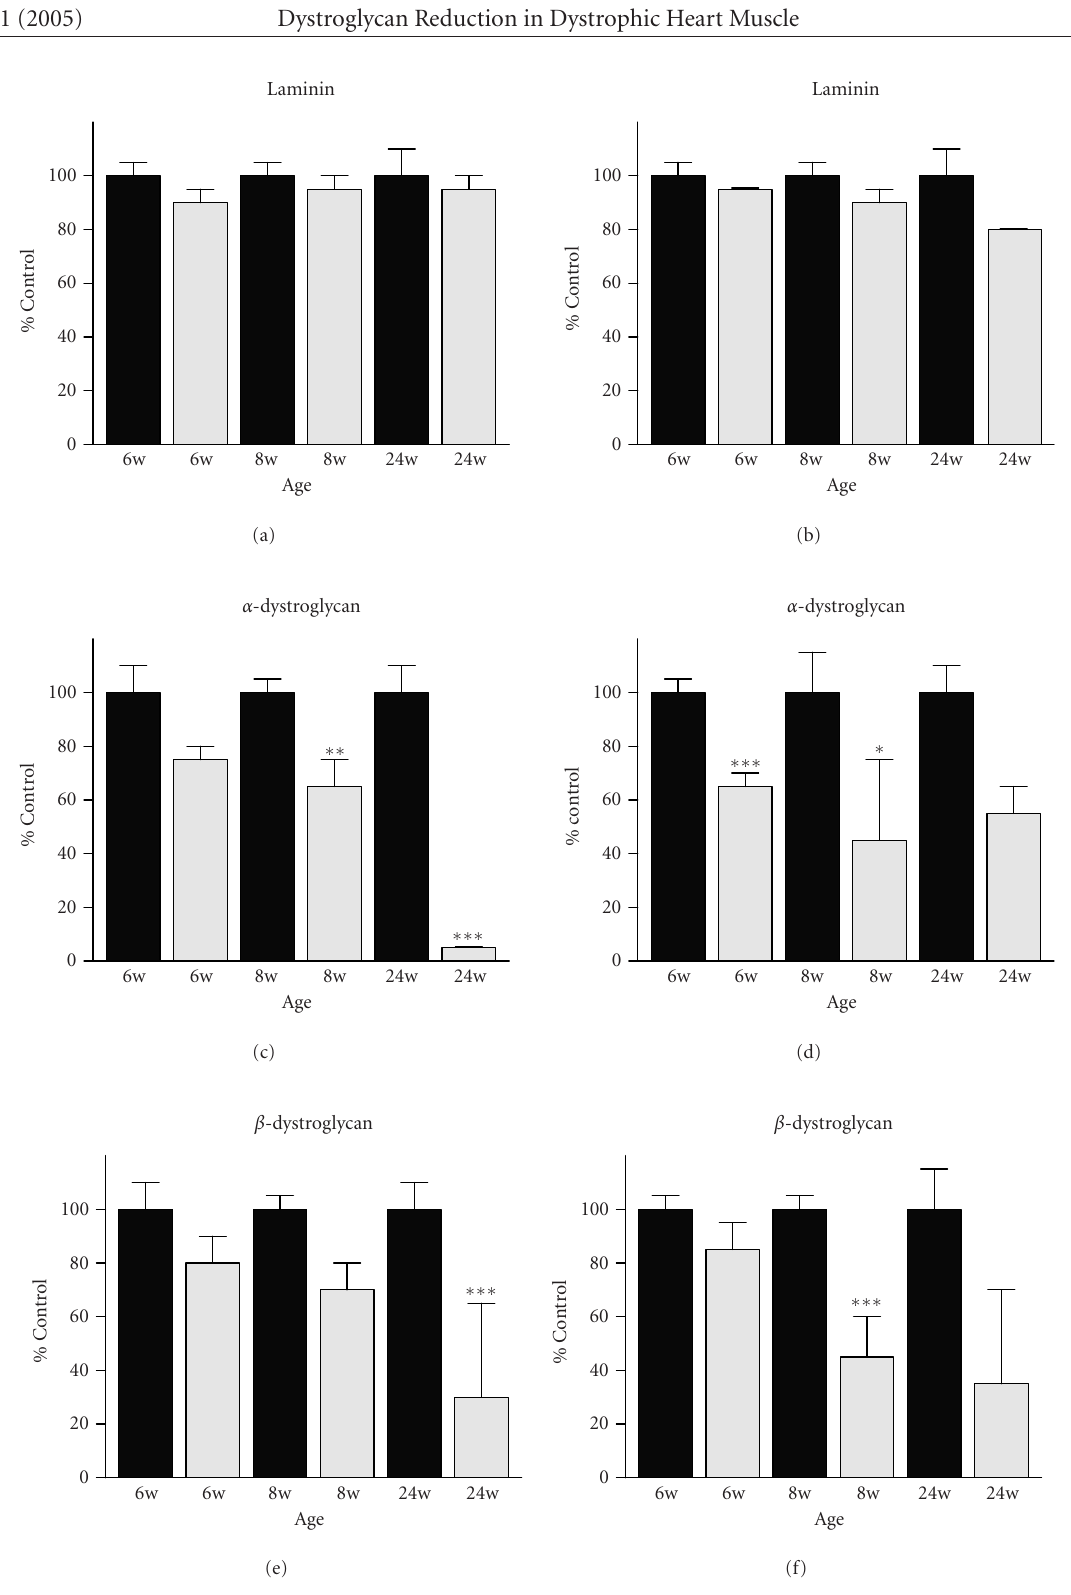
Figure 4. Comparative immunoblot analysis of dystroglycan expression in dystrophic heart and skeletal muscle. Shown is the graph- ical presentation of the immuno-decoration of laminin ((a),(b)), α -dystroglycan ((c),(d)), and β -dystroglycan ((e),(f)) in normal (black bars) and dystrophic mdx (grey bars) membrane preparations from both skeletal ((a),(c),(e)) and cardiac ((b),(d),(f)) muscles ( n = 5; SEM; ∗ P < . 05; ∗∗ P < . 01; ∗∗∗ P < . 001). Specimens were taken from 6-, 8-, and 24-week-(w-)old